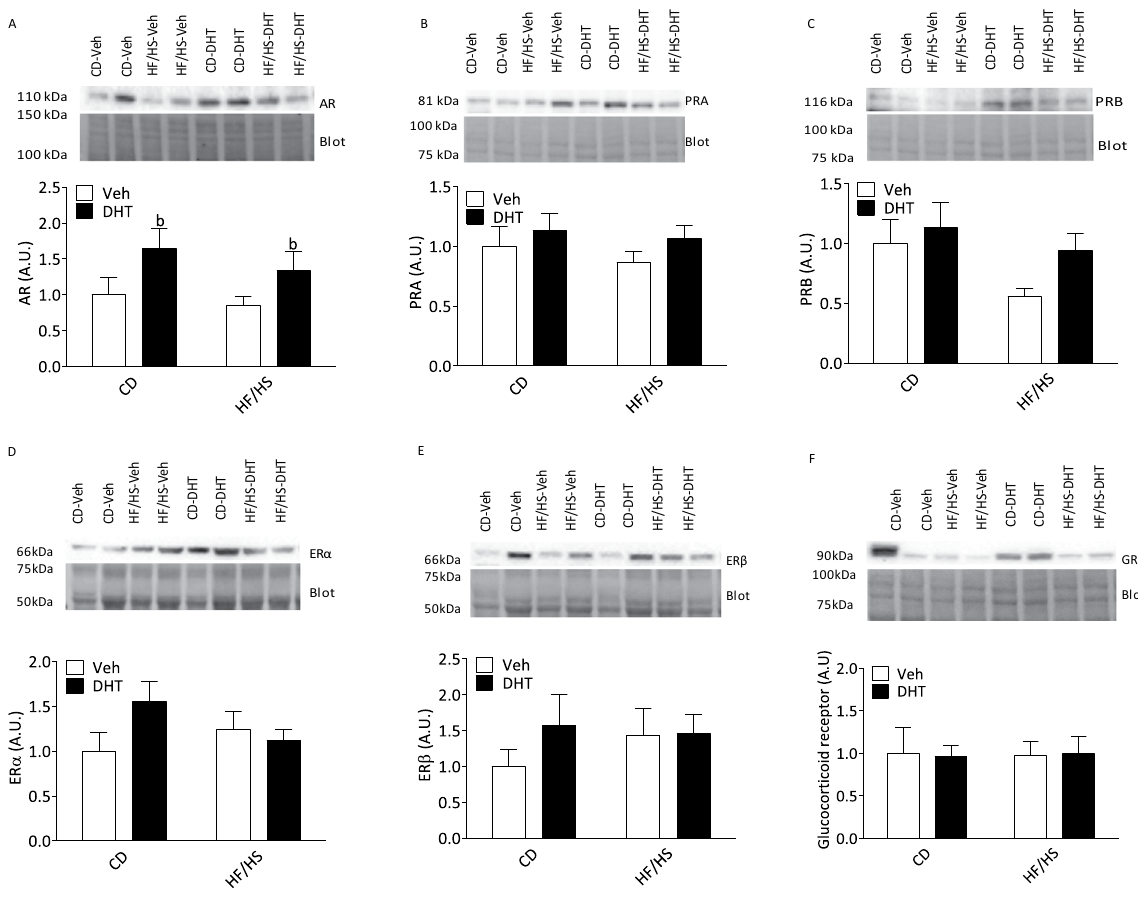
Figure 3. Protein expression of sex steroid receptors in placental homogenates on GD 18.5 ( A ) Androgen receptor (AR), ( B ) Progesterone receptor A (PRA). ( C ) Progesterone receptor B (PRB), ( D ) Estrogen receptor (ER) α , ER α . ( E ), Estrogen receptor β , ER β . ( F ) Glucocorticoid Receptor (GR). (CD-Veh, n = 8; HF/ HS-Veh, n = 8; CD-DHT, n = 8; HF/HS-DHT, n = 10). Protein expression was quantified by Western blot and normalized to total protein loaded in each line in the stain free blot. All blot images were cropped for publication, and the full images are is shown in Supplementary Fig. 5. Values are means ± SEM. a = Main effect of diet p <